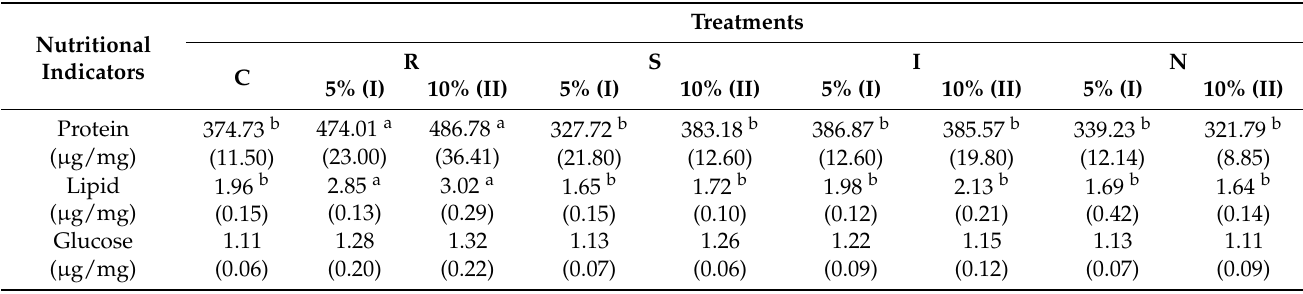
Table 5. Body composition of G. columna after 8 weeks of feeding with different aquaculture feeds. Nutritional Indicators